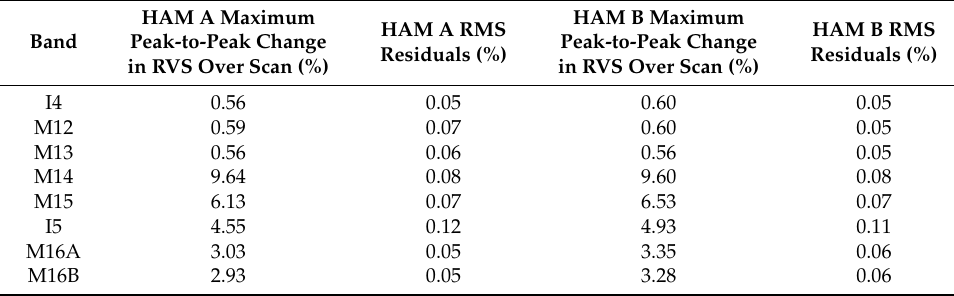
Table 6. Maximum RVS Variation across Scan and Characterization Uncertainty for all TEBs.